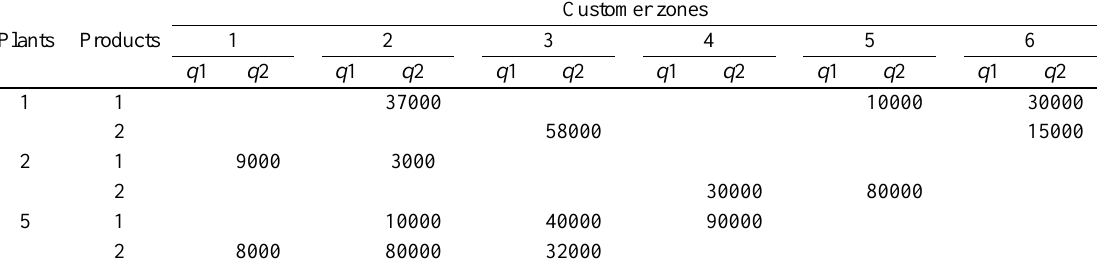
Table 15. Market share for each